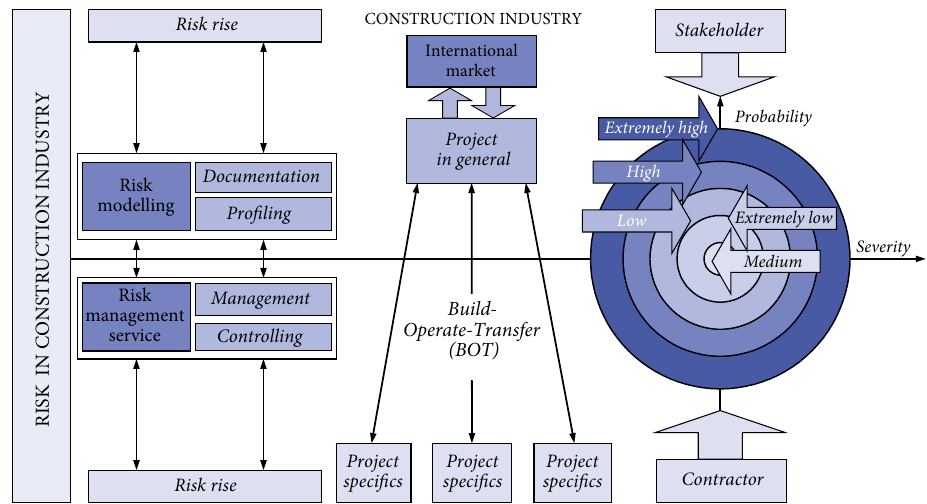
Fig. 1. Risk model in construction